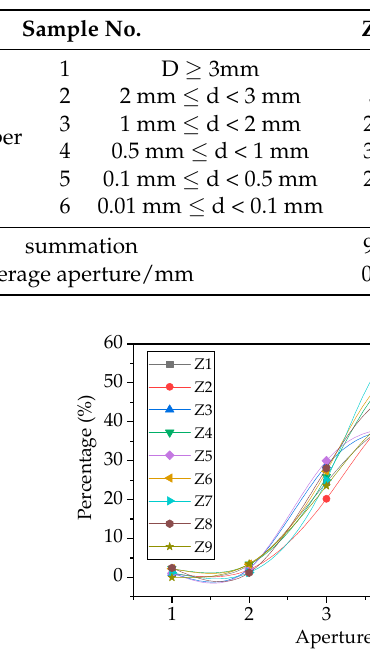
Figure 3. Diagram of aperture distribution in foam glass samples.